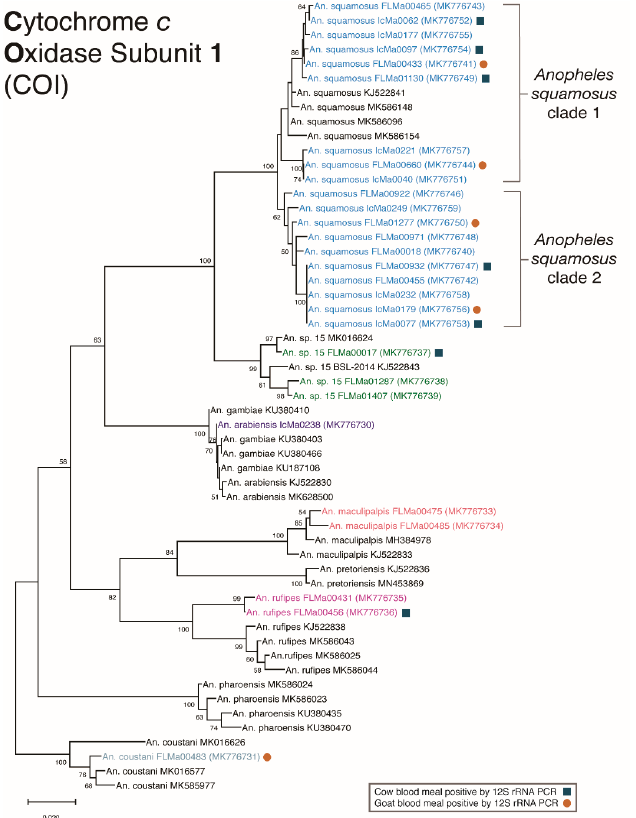
Figure 2. Cytochrome oxidase subunit I (COI) Maximum Likelihood tree. Bootstrap probabilities of branches are displayed at the nodes. Samples from this study are displayed in color by species, and samples from the NCBI database are shown in black. Evolutionary analyses were conducted in MEGA X. The phylogenetic tree was created using the Maximum Likelihood method and Gen- eral Time Reversible substitution model, with 1000 bootstrap replicates. The above tree with the highest log likelihood ( − 3804.22) is drawn to scale. This analysis contained a total of 55 total sam- ples, including 28 from this study and 27 representative sequences from NCBI BLASTn with la- beled accession